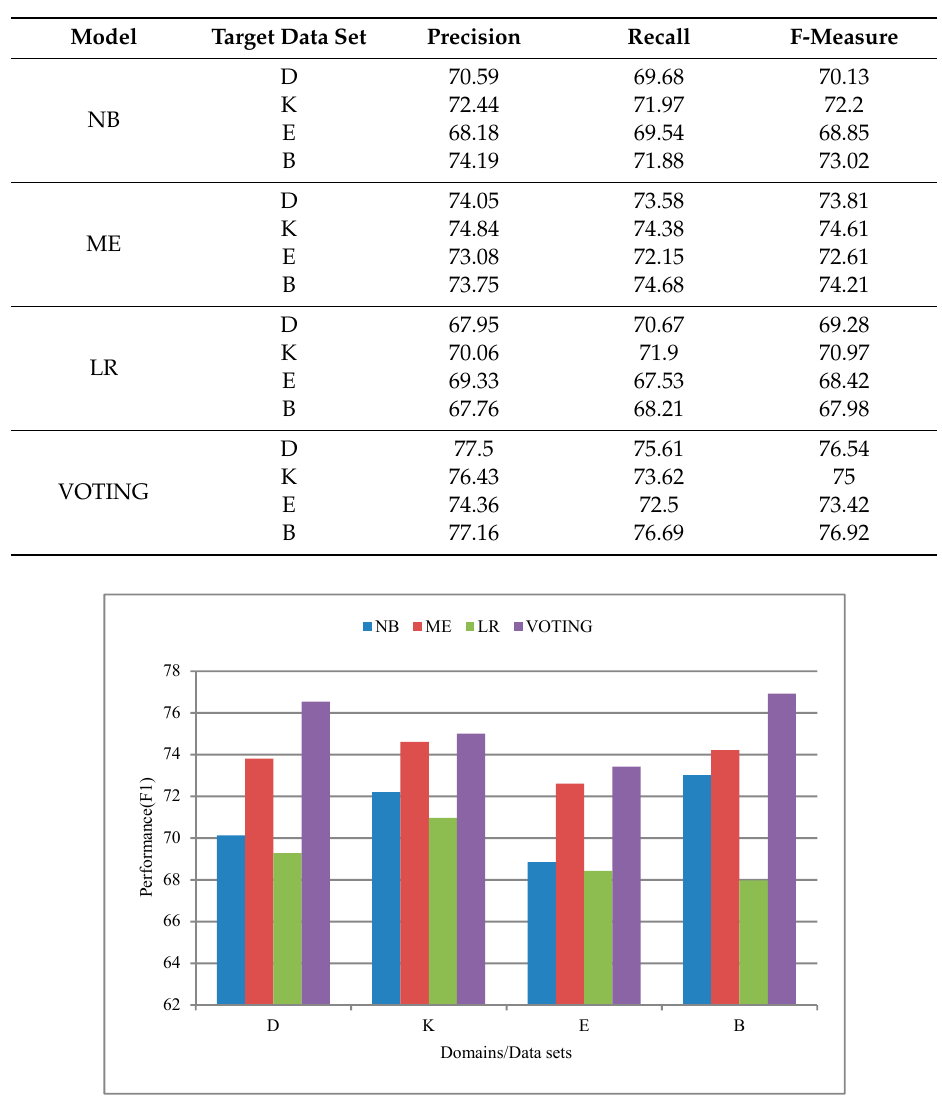
Table 2. Performance of baseline supervised learning models.